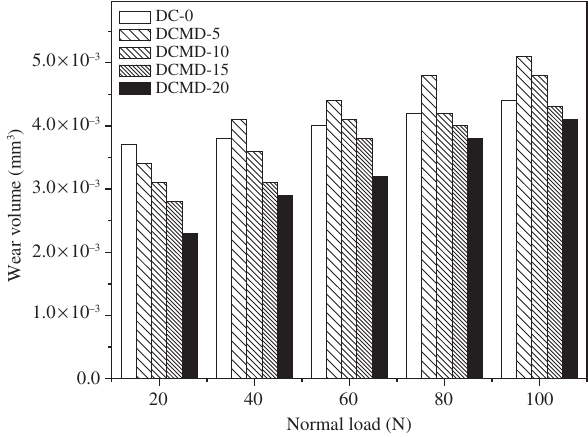
Figure 6: Effect of sliding speed on wear volume of the nanoalumina-filled dental composites.